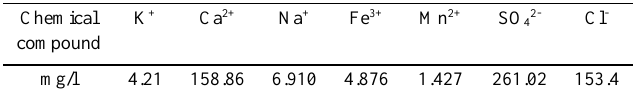
Table 1. Chemical compositions of the acidic water used.